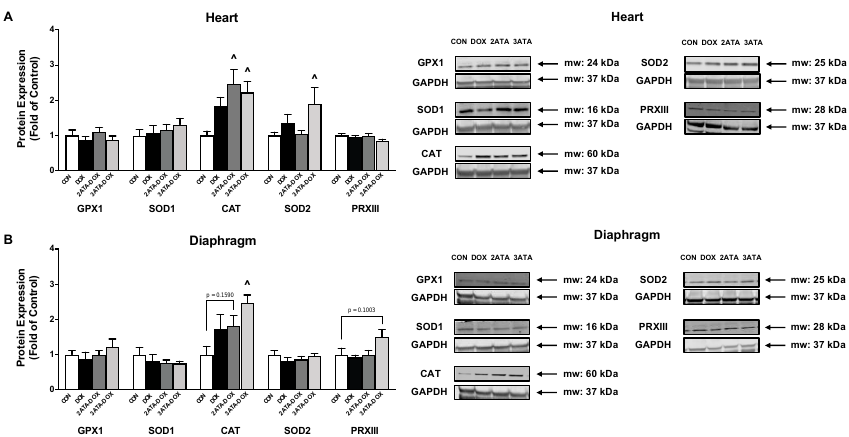
Figure 6. Antioxidant Expression. Protein expression of the endogenous antioxidants glutathione peroxidase 1 (GPX1), superoxide dismutase 1 (SOD1), catalase (CAT), superoxide dismutase 2 (SOD2), and peroxiredoxin III (PRXIII) in the ( A ) heart and ( B ) diaphragm. Representative Western blot images are shown to the right of the graphs. Values are represented as means ± SEM. ^ = significantly different vs. CON ( p < 0.05).